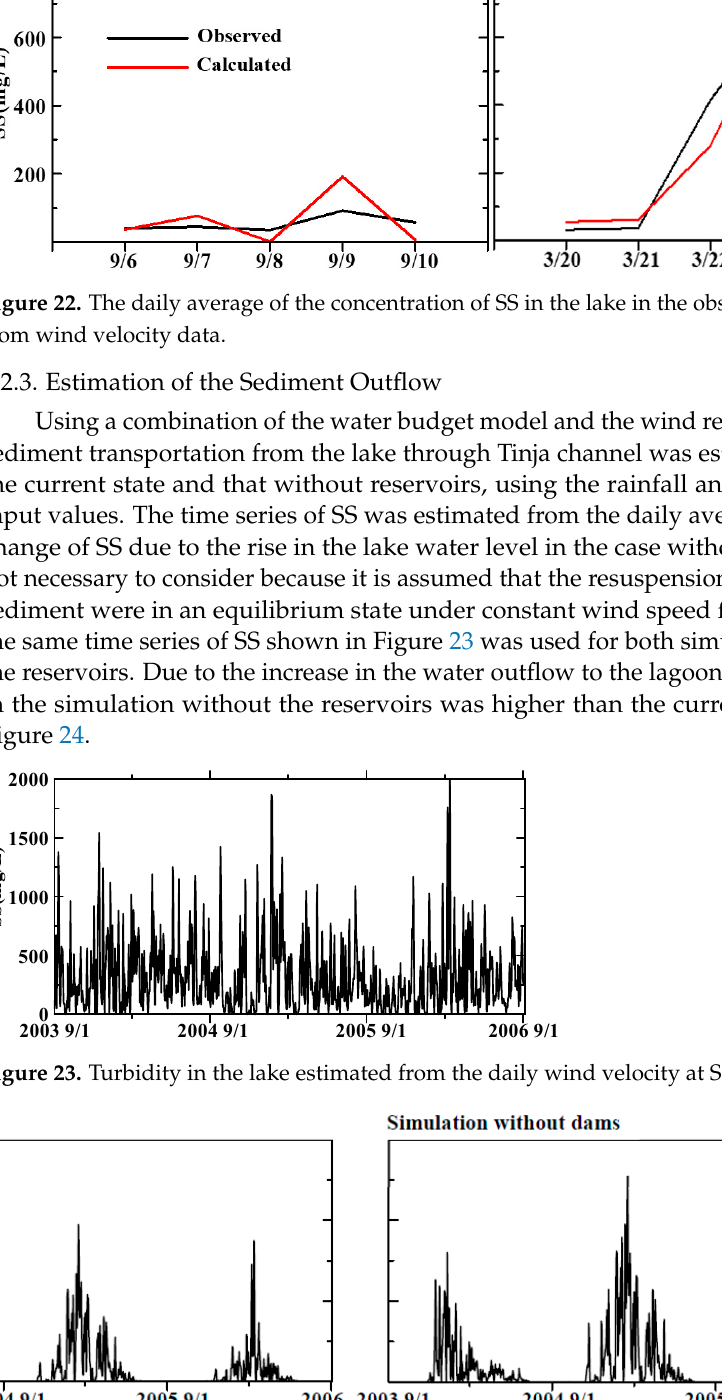
the observation periods.